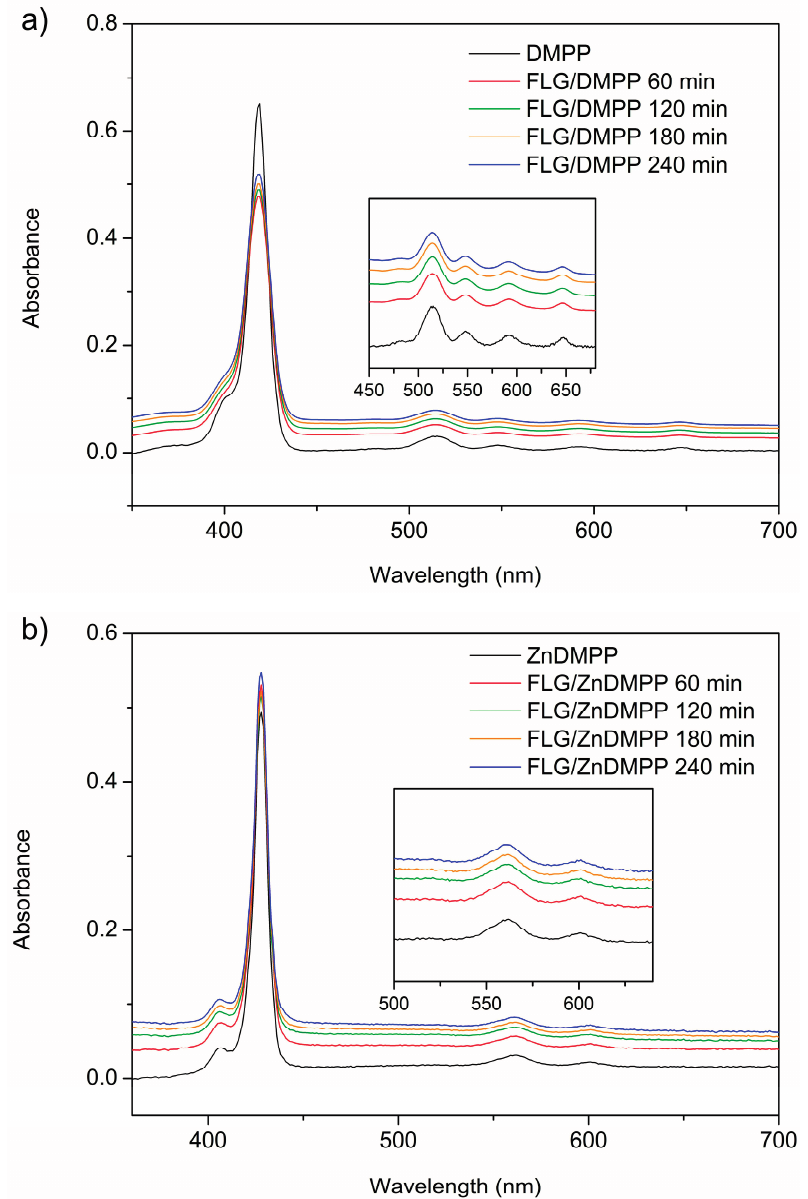
Figure 2. UV-vis absorption spectra of FLG/porphyrin hybrids recorded at different exfoliation times of graphene ( a ) FLG/DMPP; and ( b ) FLG/ZnDMPP. Insets show a magnification of the Q-bands in each case, which show similar changes to those observed for the Soret